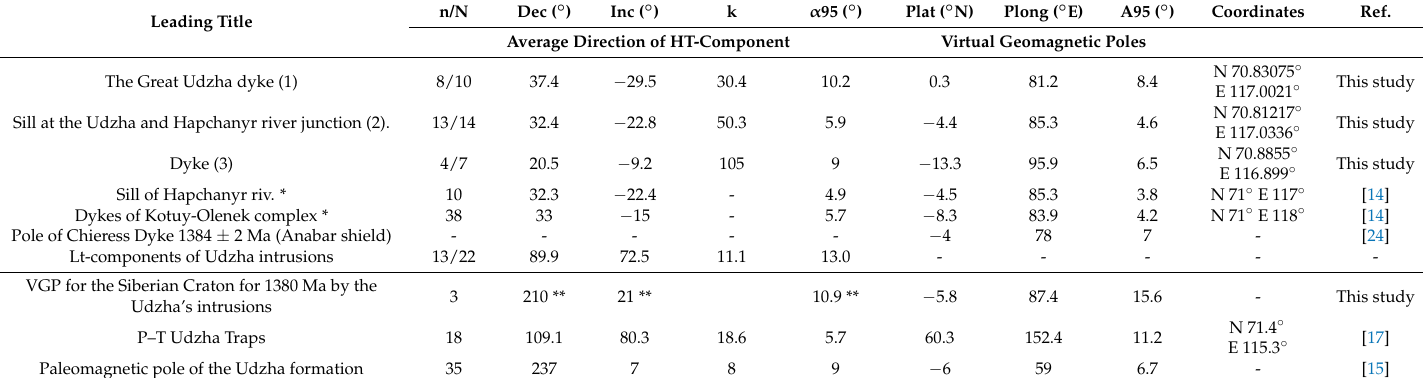
Paleomagnetic pole of the Udzha formation